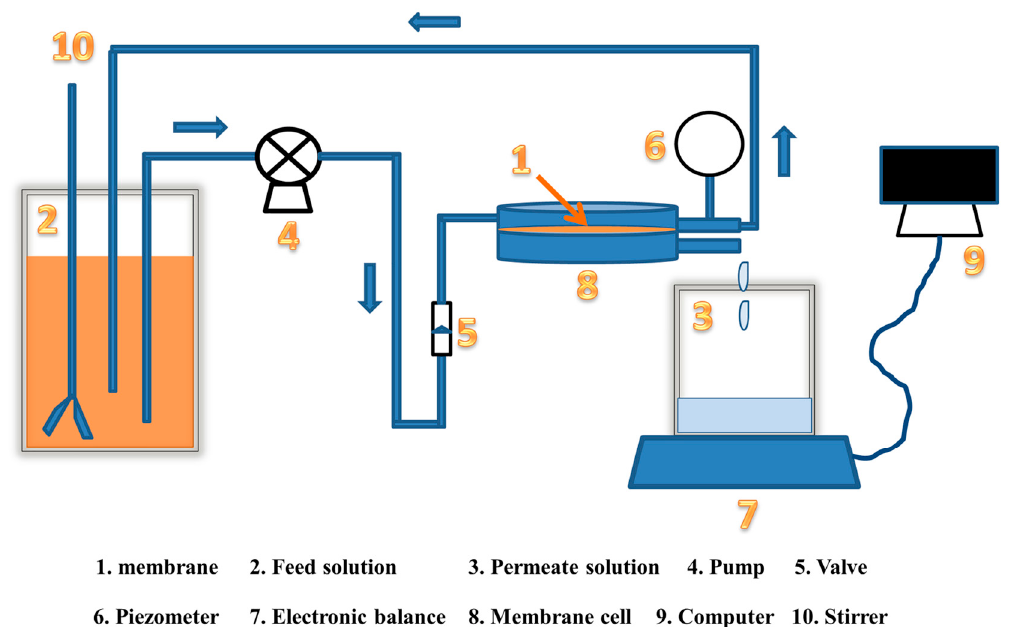
Figure 2. The crossflow filtration setup for loose Figure 2. The cross fl ow fi ltration setup for loose nano fi ltration.